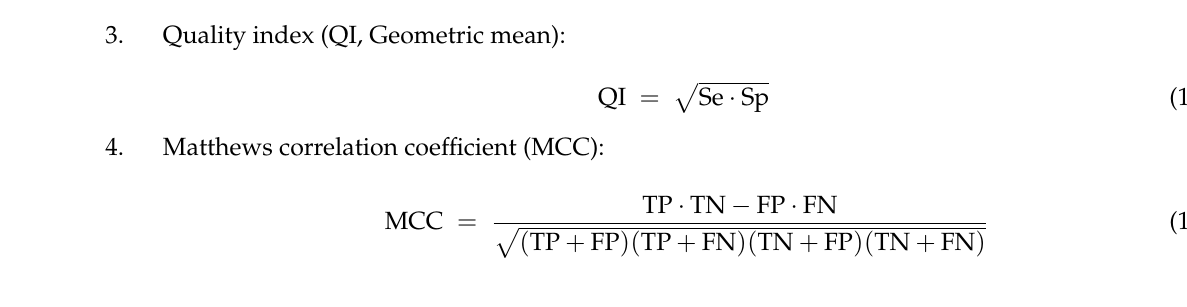
Table 2. Performance measurements for binary classification computed from a confusion matrix.